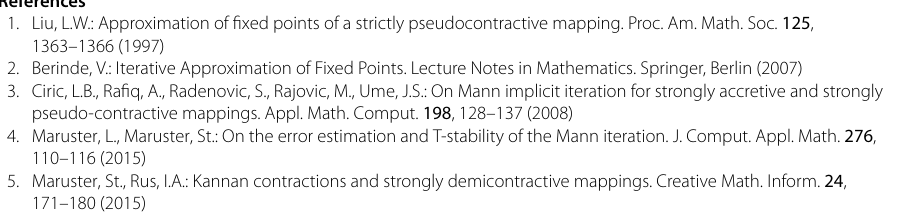
strongly demicontractive mappings (see Example 3.1 and Example 4.1), we show that the Ishikawa iteration converges faster than the Mann iteration (see Tables 1–2, Fig. 1 and Fig. 3), but the Mann iteration is more efficient for the error estimation (see Fig.